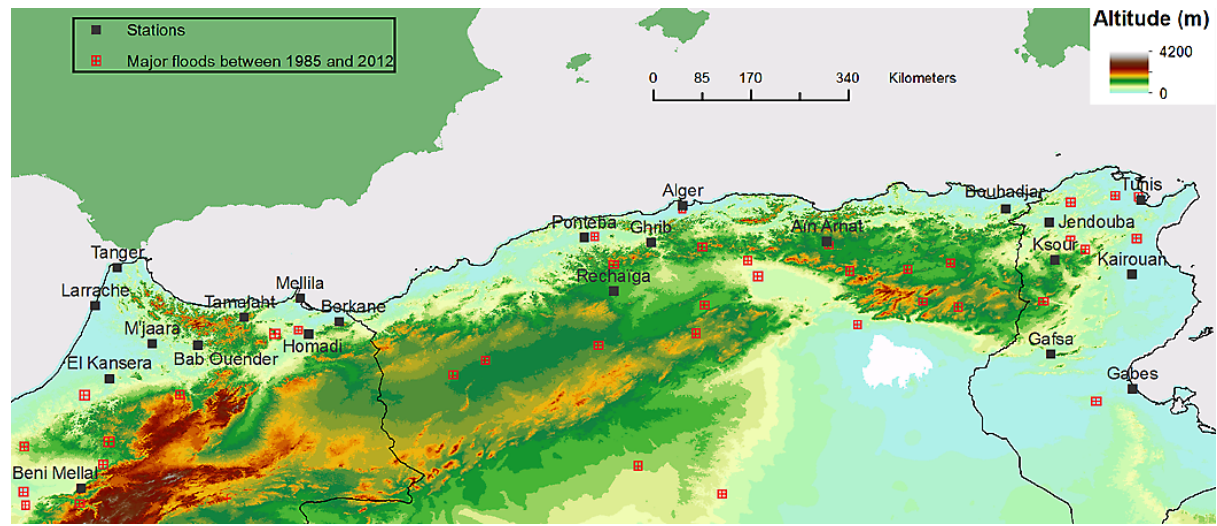
Fig. 2. Map of the selected stations and centroids of the areas affected by floods between 1984 and 2012 (data from G. R. Brakenridge, “Global Active Archive of Large Flood Events”, Dartmouth Flood Observatory, University of Colorado, http://floodobservatory.colorado. edu/Archives/index.html). Table 1. Stations with precipitation data (the full years are those with less than 5% missing data during the hydrological